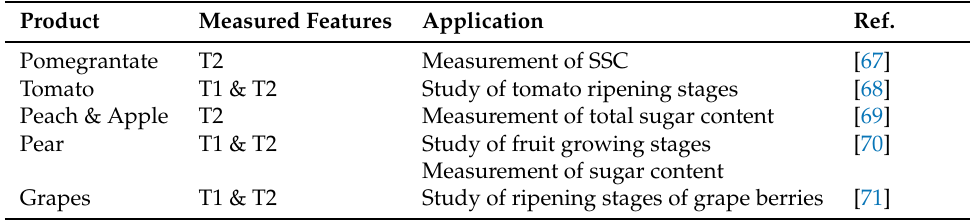
Table 5. Summary of MRI methods reported in various